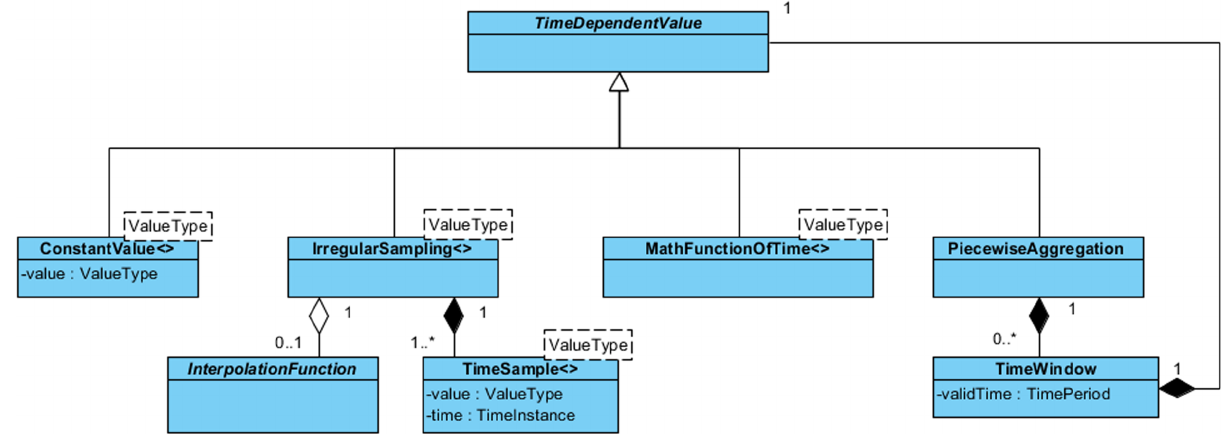
Fig. 7. UML diagram of property value types in